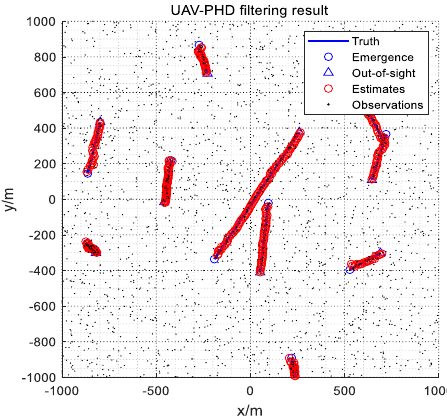
Figure 6. Filter results of UAV-PHD filter.